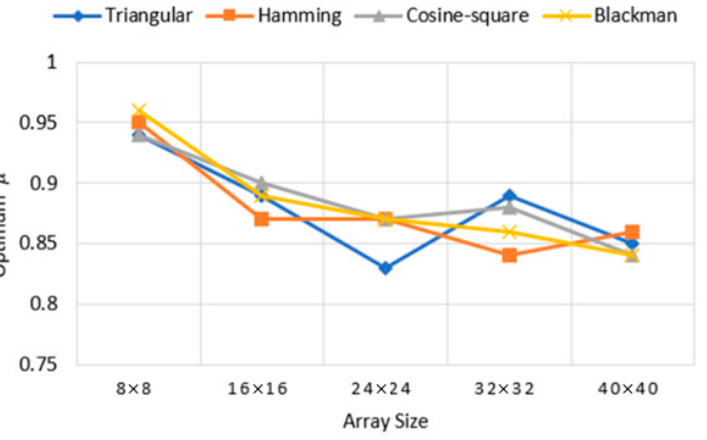
Figure 12. Optimum edge tapering factor variation with the array size for different radial tapering extrapolated 2D windows.